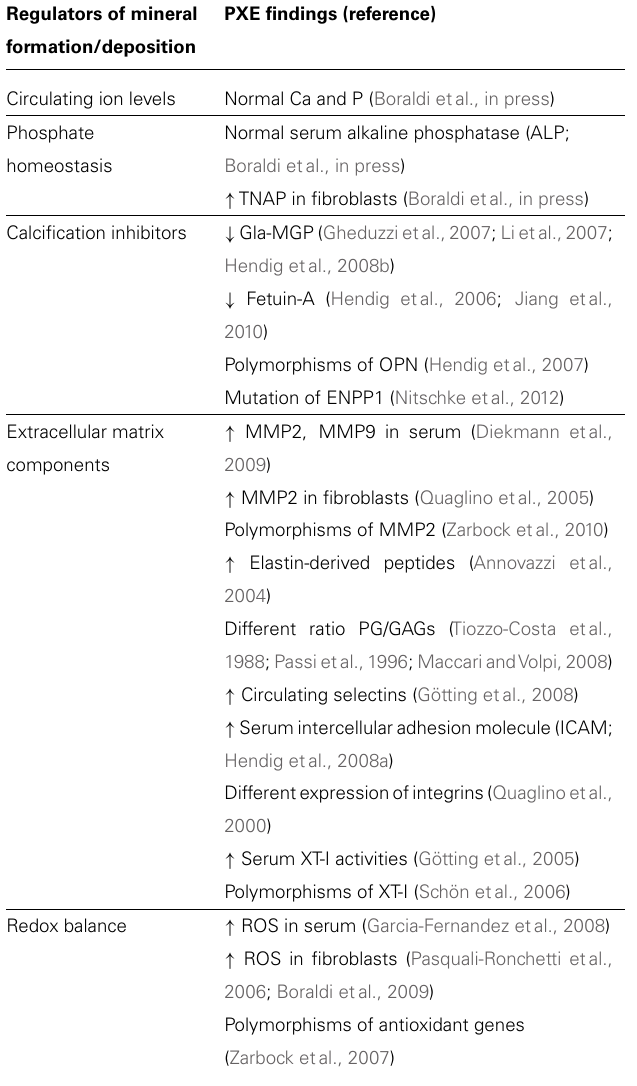
Table 1 | Genes/molecules involved in the regulation of elastic fiber calcification in PXE. Regulators of